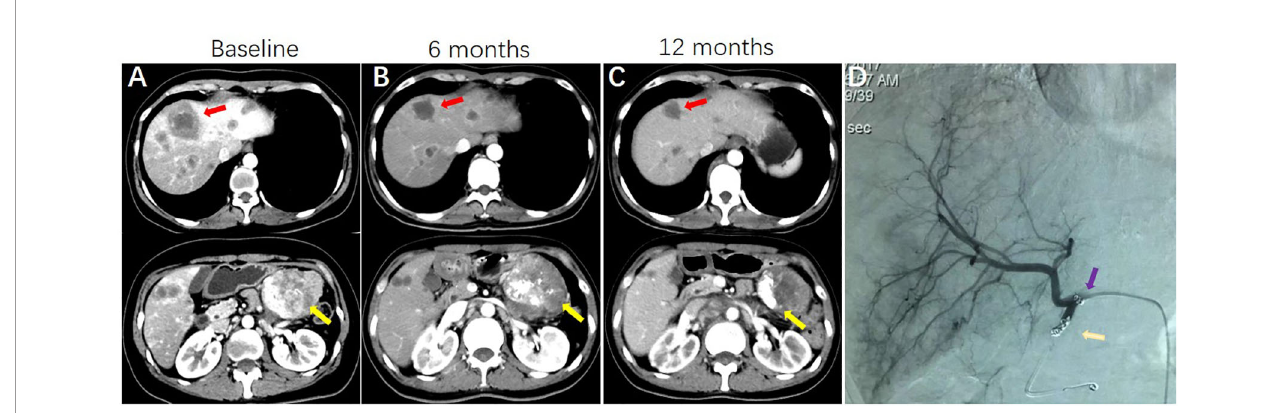
FIGURE 1 | A patient with pancreatic cancer and synchronous liver metastases, who was treated with systemic GC HAI FUDR. (A) CT images showing the presence of pancreatic cancer (yellow arrows indicate) and synchronous liver metastases (red arrows indicate) at baseline. (B) CT images show primary cancer and liver metastases are shrinking at 6 months. (C) images show sustained response of liver metastases and primary cancer. (D) Hepatic arteriography shows HAI pump functionality at 12 months (purple arrow indicates side hole of the catheter; gold arrow indicates the tip of the catheter, which was located in the occluded gastroduodenal artery).